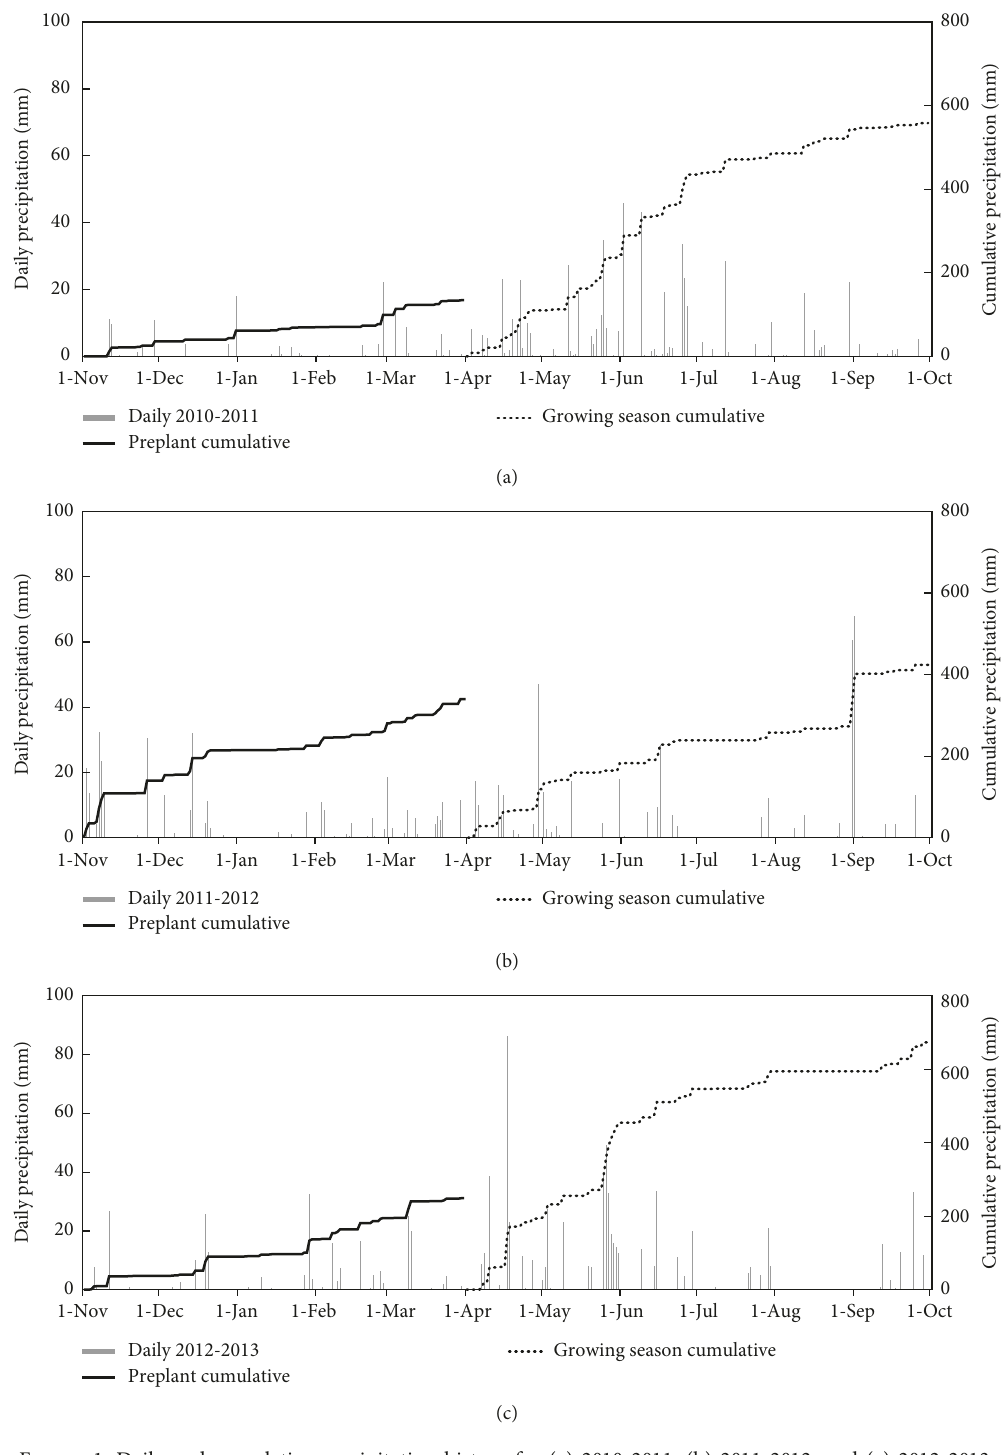
Figure 1: Daily and cumulative precipitation history for (a) 2010-2011, (b) 2011-2012, and (c)